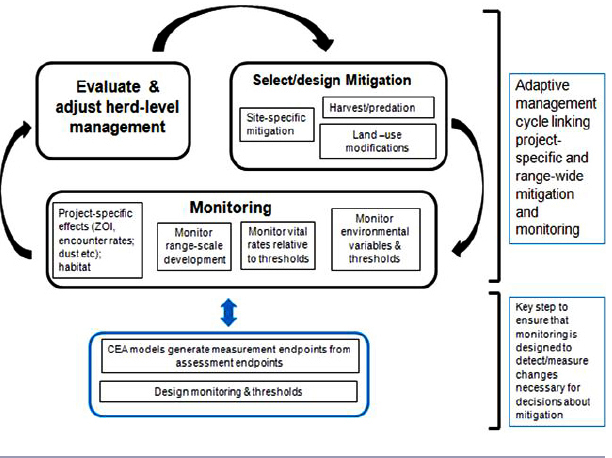
Fig. 2. Response framework for cumulative effects illustrating monitoring